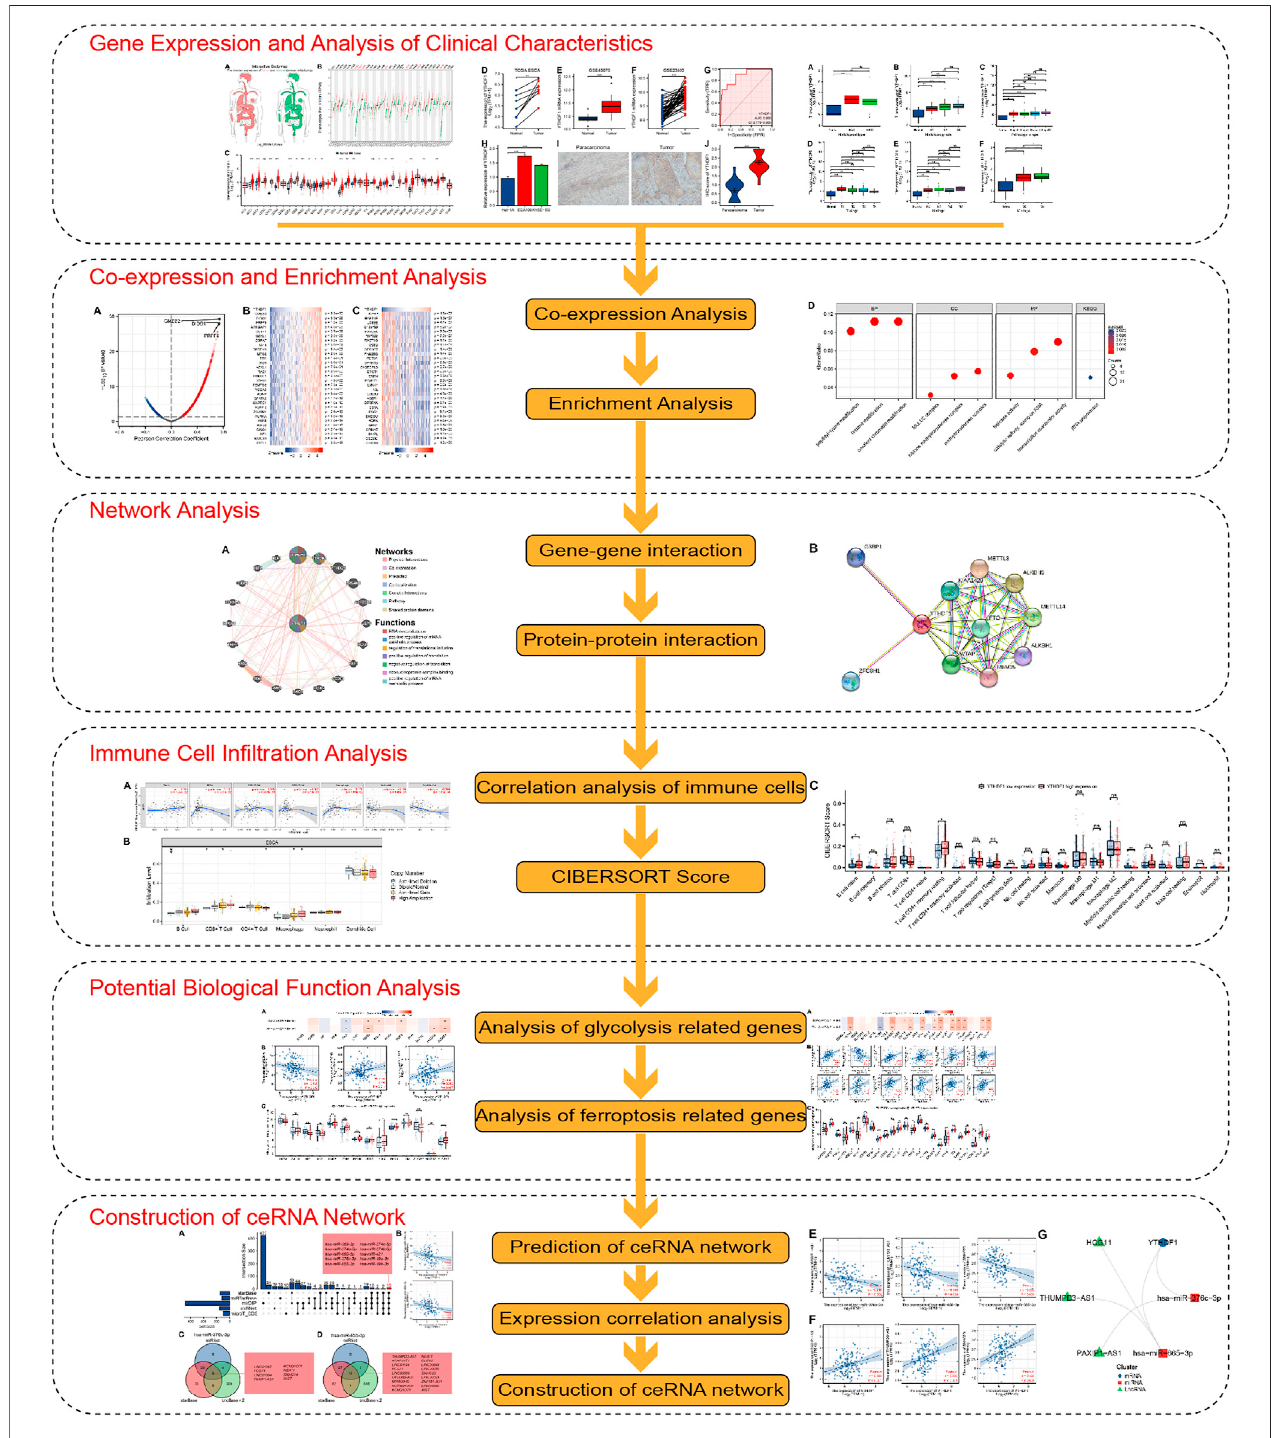
FIGURE 1 | Schematic diagram of the study